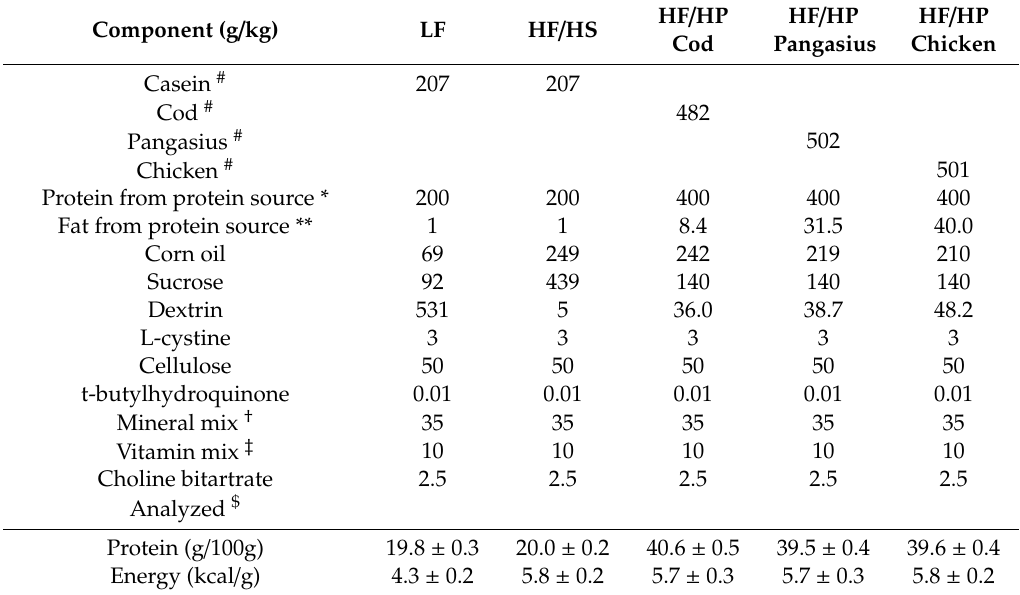
Table 3. Dietary composition of LF 1 , HF / HS 2 and HF / HP 3